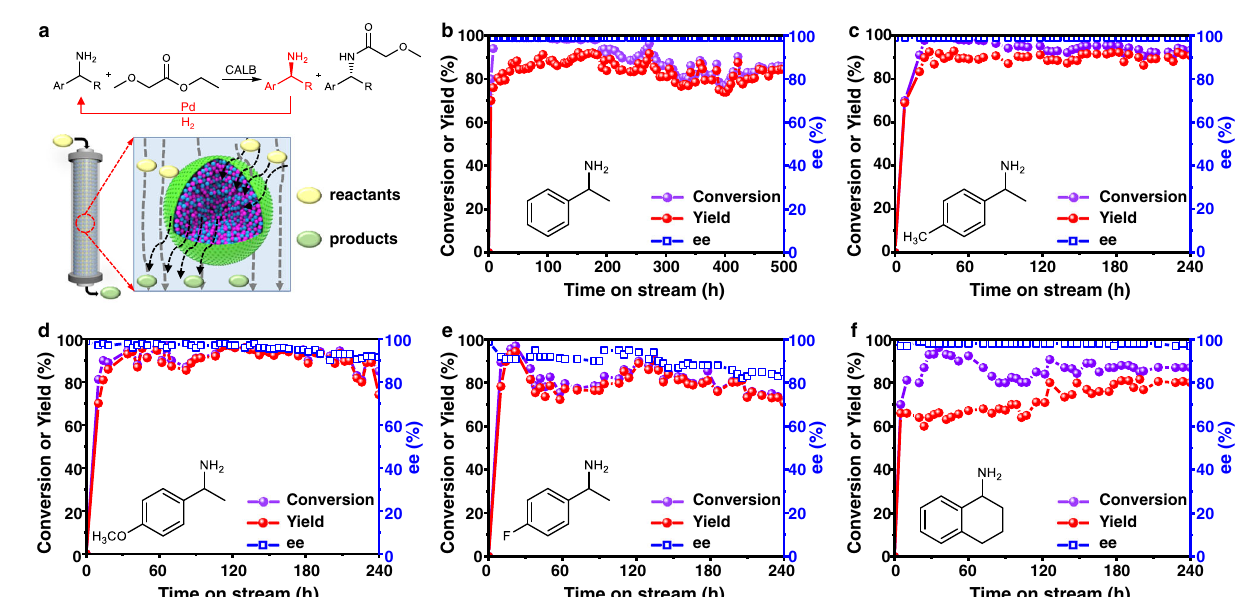
Fig. 5 | Results of the cascade of hydrogenation and kinetic resolution over different catalysts. a Reaction network of the cascade reaction. b Schematic illustrationofthestructuresof fi veanalogouscatalysts. c Recyclabilityofthese fi ve catalysts, reaction conditions: 0.2mmol acetophenone, 0.8mmol vinyl acetate, 2.0mL n -octane, 50°C, 2MPa H 2 , 6h, S/C=56:1 (substrate to Pd), 3.52 – 3.55 μ mol Pd and 1.40 – 1.42mg CALB applied for all the batch reactions. d Results of the cascade reaction overdifferent catalysts, reaction conditions are the sameasin ( c )